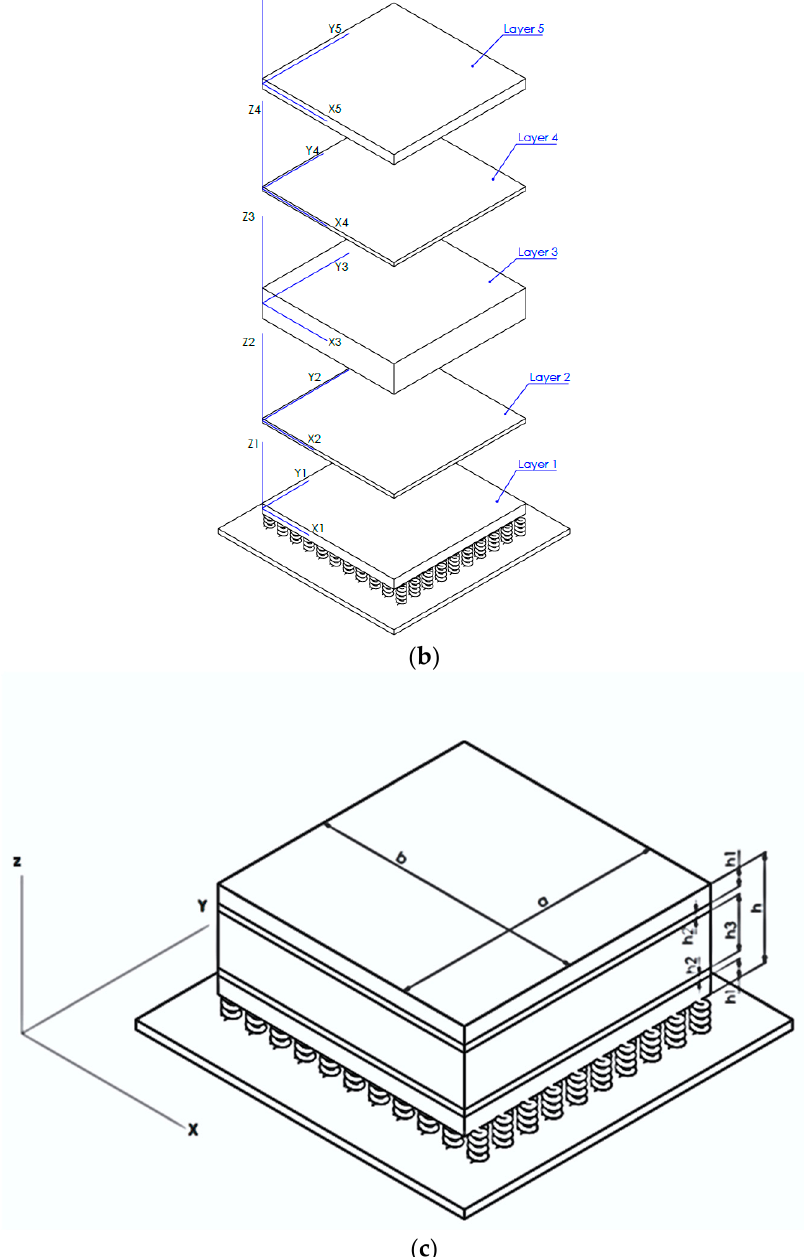
Figure 1. The five-layer simply supported sandwich plate with functional face sheets resting on elastic foundation. ( a ) Structural constituents of the sandwiched composite plate. ( b ) Coordinate System for each layer. ( c ) Structural dimensions of the sandwiched composite plate.